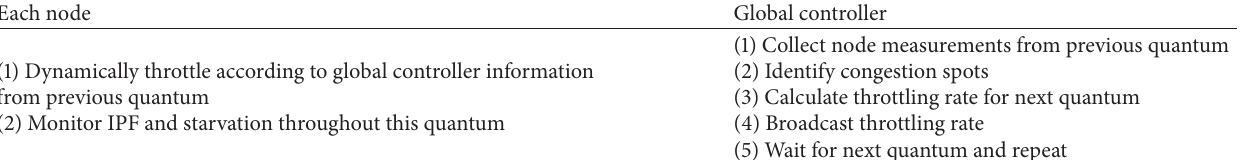
Table 1: Interval-based QBLESS congestion control.